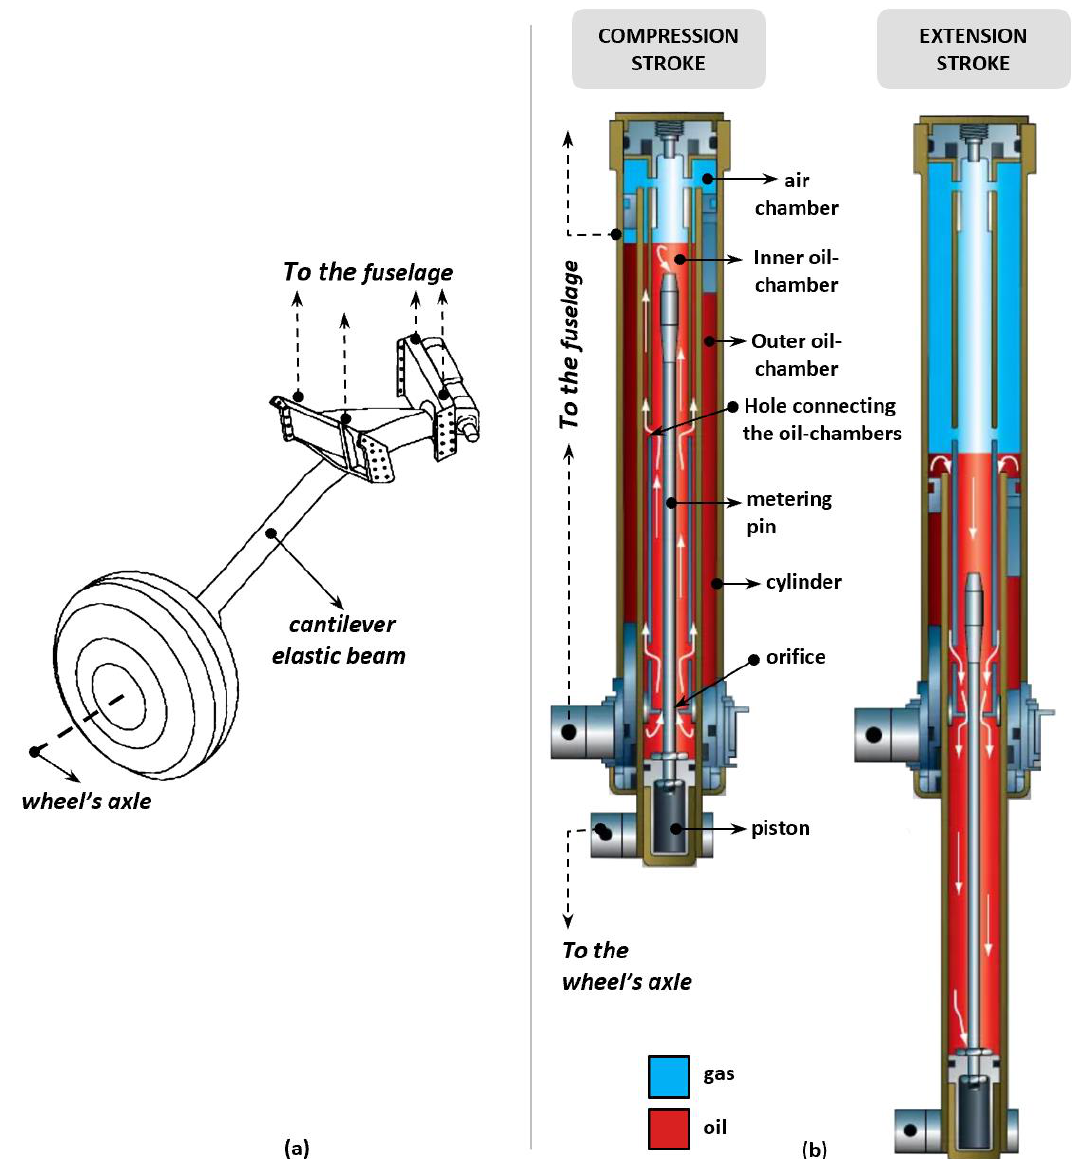
Figure 1. Main types of landing gear: ( a ) cantilever strut [2] and ( b ) oleo-pneumatic shock-absorber [3]. The piston-cylinder assembly is generally referred to as a shock absorber , and the dissipative force generated during the landing is mainly due to the flow of viscous oil into an orifice with a cross-section that varies with the piston stroke. In more detail, the oil flows between two coaxial chambers, depending on the direction of motion of a tapered metering pin mounted on the piston (Figure 1b). During the compression stroke, the metering pin enters the inner chamber through an orifice with net section area A s ; to compensate for the reduction in the amount of available volume, part of the oil contained in the inner chamber moves into the outer chamber, flowing into the same orifice crossed by the metering pin and into some holes connecting the two chambers. At the same time, the gas contained in a compensation air chamber (placed at the top of the oil chamber) is compressed, thus contributing to the balance of fluid volume in the different compartments of the cylinder.